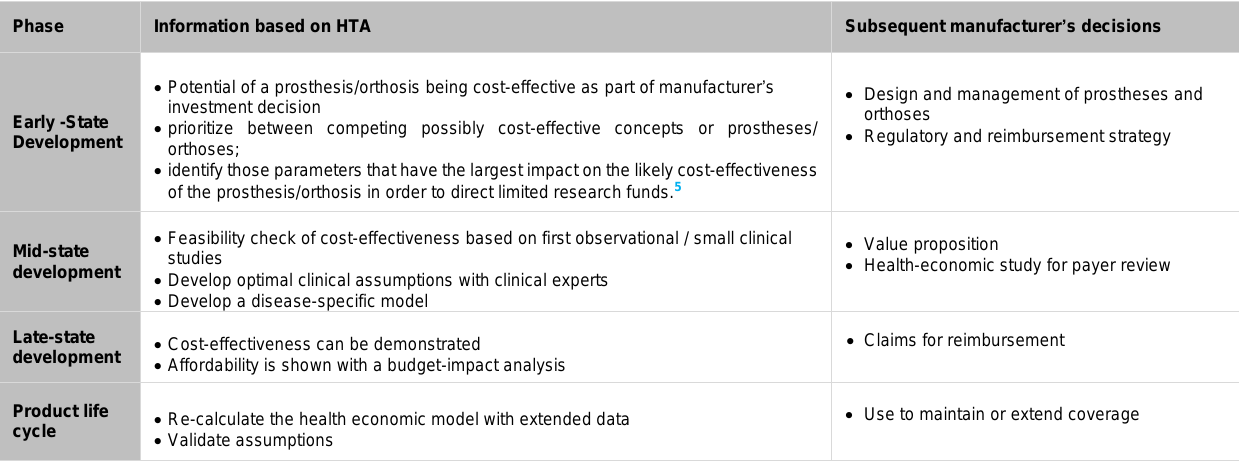
Table 2 : Health Economic Analyses in the R&D Process of manufacturers and in the product life cycle. 82